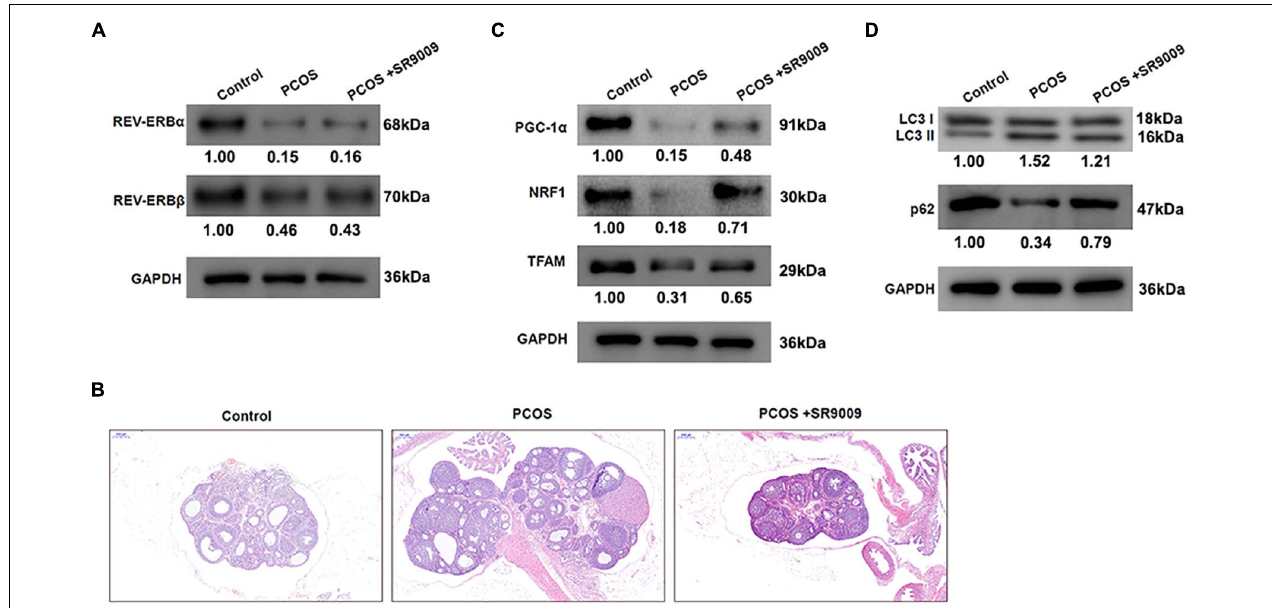
FIGURE 6 | REV-ERBs agonist SR9009 prevents abnormal follicular development by regulating mitochondrial biosynthesis and autophagy in PCOS animal models. Female Sprague Dawley rats were injected with DHEA to construct the PCOS model, and treated with SR9009 or saline by i.p. twice per day for 1 week and then once a day for a further week. (A) The expression of REV-ERBs was detected by western blotting. (B) Representative images of H&E staining of ovarian tissues from rats in each group. Scale bars: 200 µ m. (C) Genes related to mitochondrial biogenesis protein levels in ovarian tissues detected by western blotting. (D) The expression of LC3 and p62 was detected by western